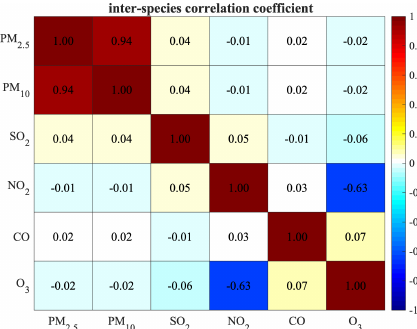
Figure B1. Correlations between species in the background error covariance matrix, estimated from the LETKF ensemble averaged from 2013 to 2018. The global mean of the covariance estimated for each station is plotted.